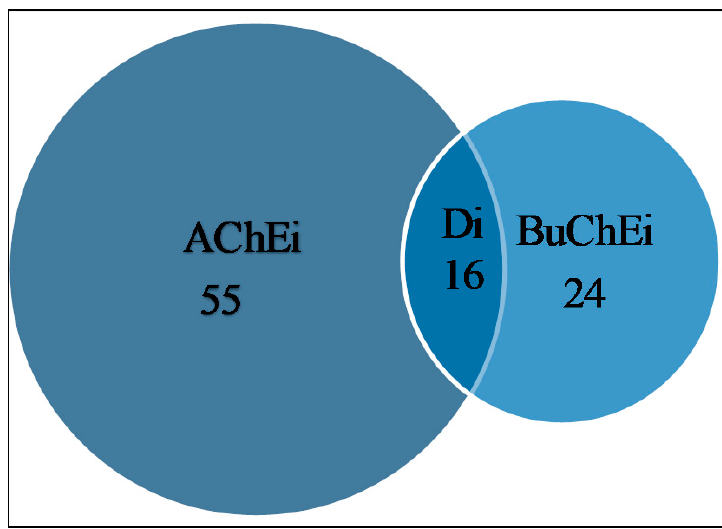
Figure 2. Potential cholinesterase enzyme inhibitors with IC 50 ≤ 10 μ M. AChEi represents acetyl- cholinesterase inhibitors, Di represents dual cholinesterase inhibitors, BuChEi represents butyryl- cholinesterase inhibitors. Table 1. Alkaloids from different species and respective IC 50 towards AChE and BuChE. Species Part